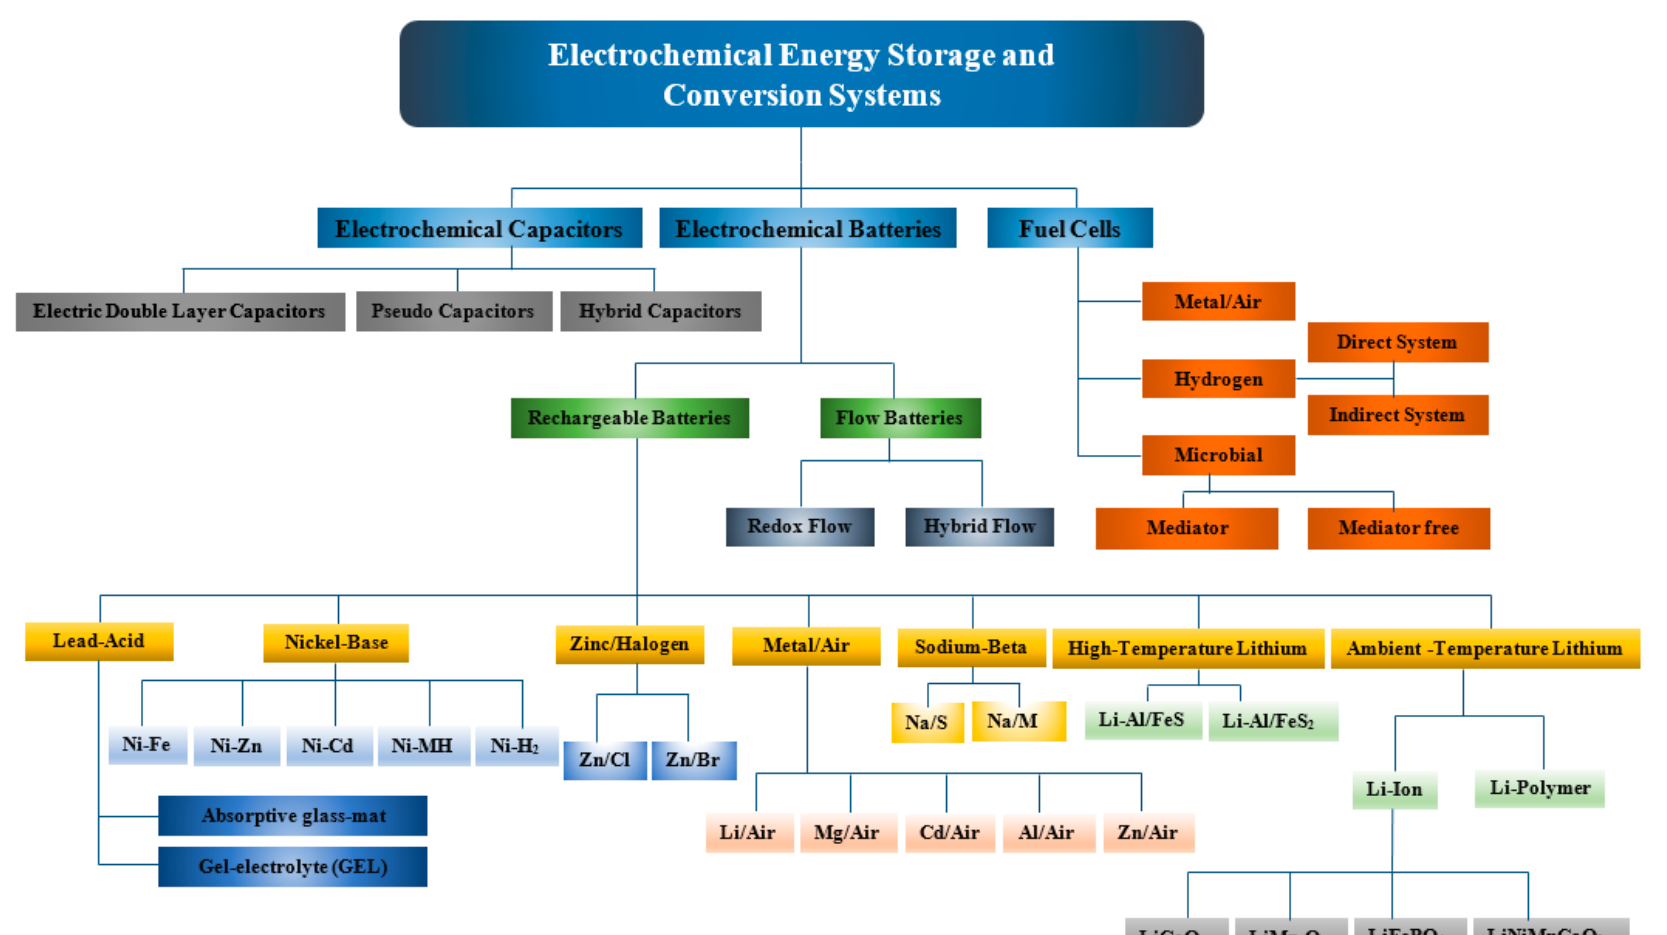
Figure 1. Classification of electrical energy storage and conversion devices.